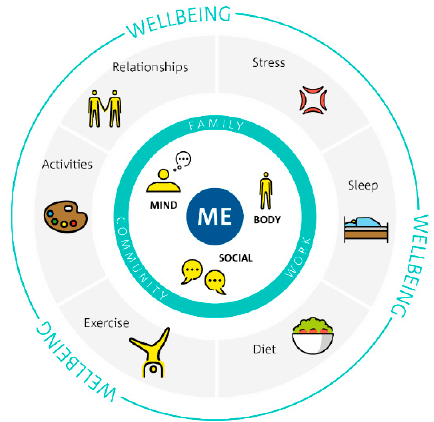
Figure 1. Wellbeing wheel (An Aviation Professional’s Guide to Wellbeing, Flight Safety Foundation, 2020).